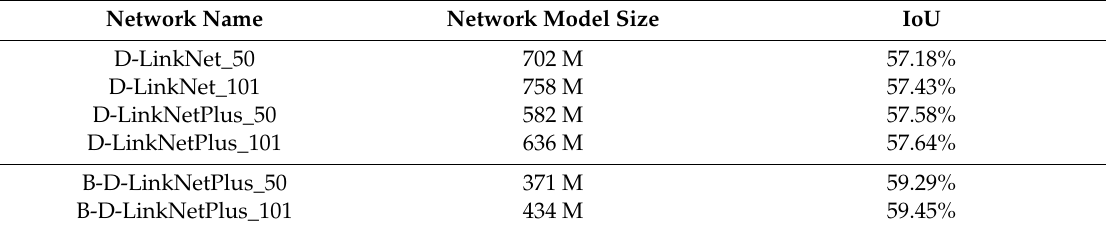
Table 4. Comparison results of road precision between D-LinkNet, D-LinkNetPlus, and B-D-LinkNetPlus.